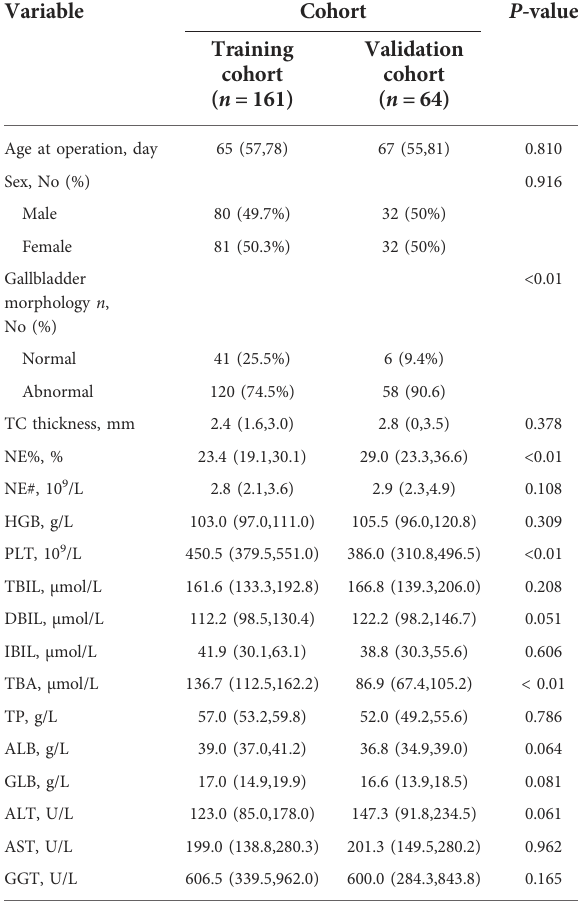
TABLE 1 Baseline clinical characteristics of infants with biliary